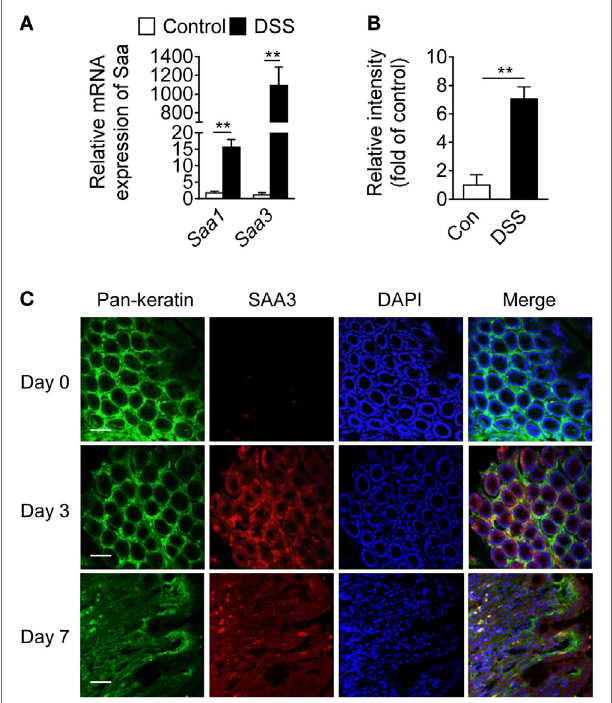
FigUre 1 | Serum amyloid A (SAA)3 expression in dextran sulfate sodium (DSS)-induced mouse colitis model. (a) Relative mRNA expression levels of Saa1 and Saa3 in colonic tissue of wild-type (WT) mice treated with control (water only) or DSS (3.5% in water), based on quantitative RT-PCR [mean ± standard margin of error (SEM), n = 5, triplicate]. (B) Relative expression levels of SAA3 protein in colonic tissue of WT mice without (open bar) and with (closed bar) 3.5% DSS treatment, based on Western blot analysis (mean ± SEM, n = 5, triplicate). (c) Representative immunofluorescence images showing SAA3 protein expression (red) in mouse colonic epithelium (green) before (day 0) and 3 or 7 days after giving 3.5% DSS in drinking water ( n = 5). Scale bar, 20 µm. ** p < 0.01 between groups. Male and female mice 8–10 weeks of age were used in all